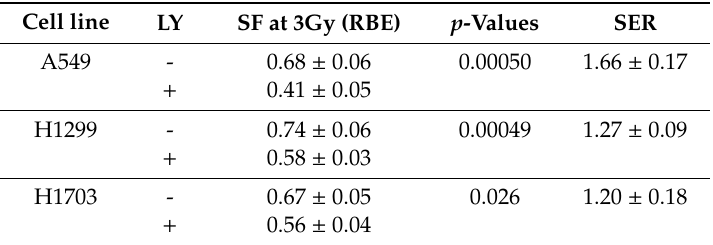
Table 2. Sensitizing e ff ect of LY2874455 on carbon